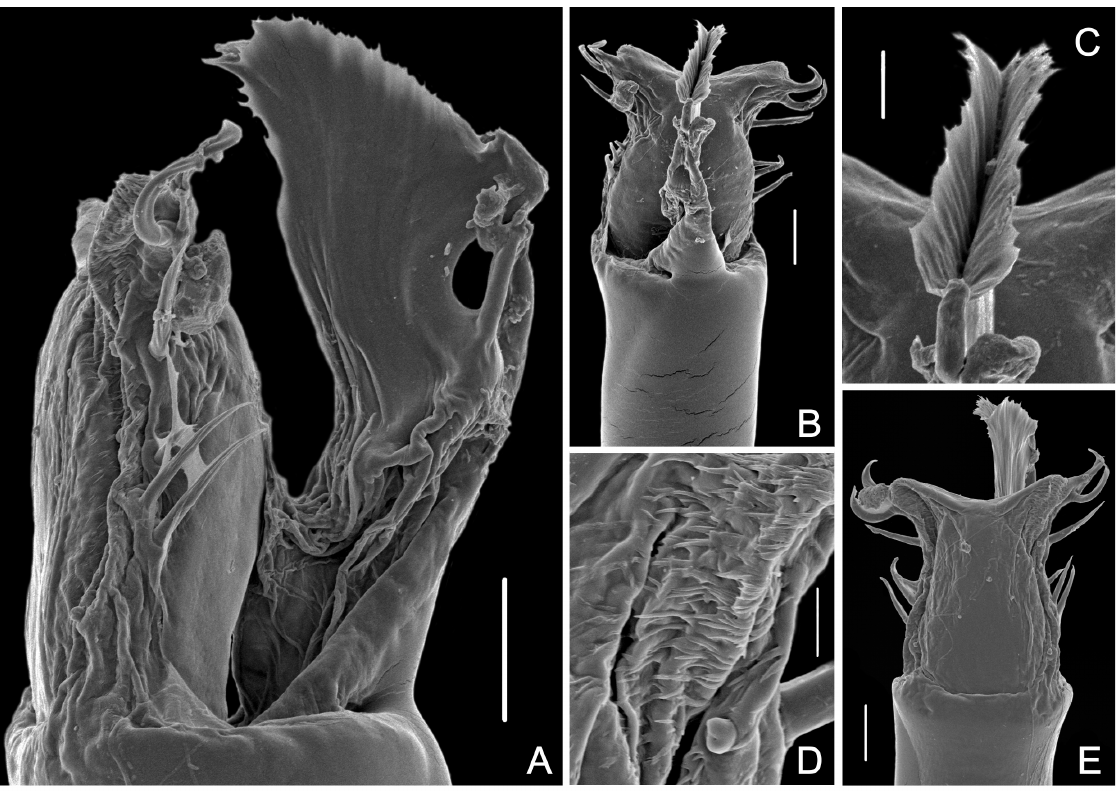
Fig. 8. Libitia cordata (Gervais, 1844), ♂ (ICN-AO 1040), distal part of penis. A . Left lateral view. B . Dorsal view. C . Stylus. D . Lateral portion of ventral plate, microsetae. E . Ventral view. Scale bars: A, E = 50 μm; B = 100 μm; C = 20 μm; D = 10